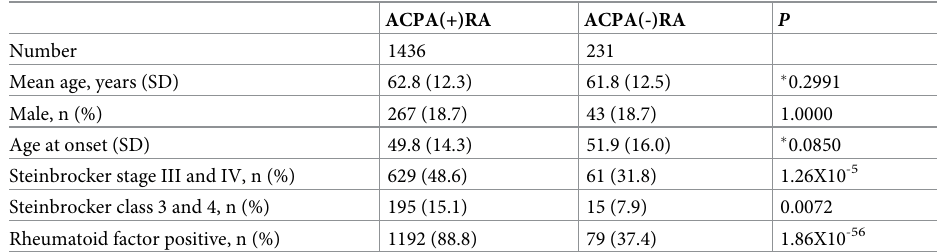
Table 1. Characteristics of RA patients.